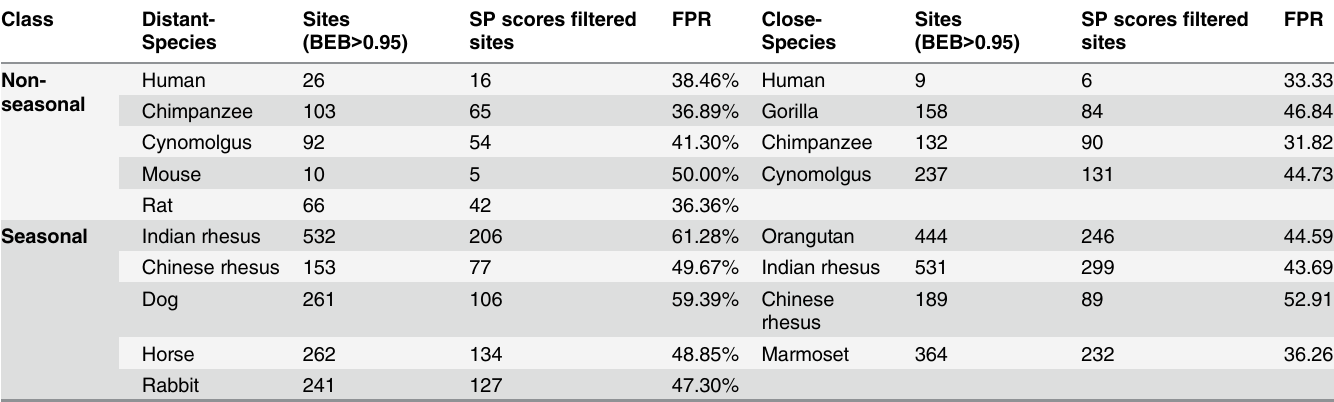
Table 2. Positive sites after BEB and SP-score